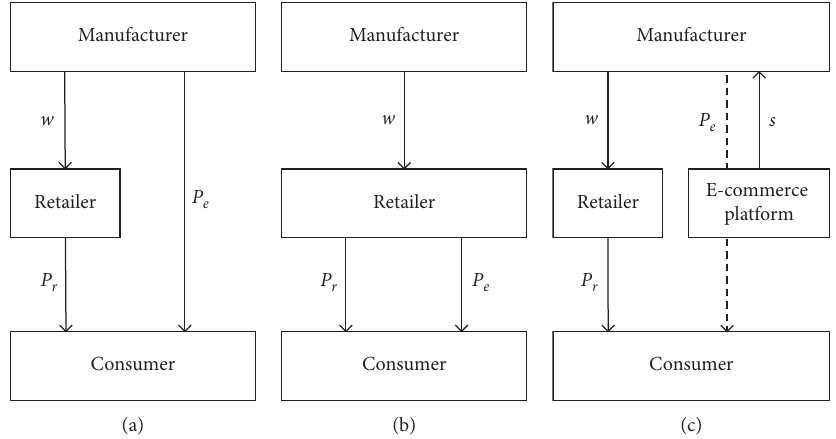
Figure 1: Structure of three online channel modes in a dual-channel supply chain, (a) model D , (b) model R , (c) model A